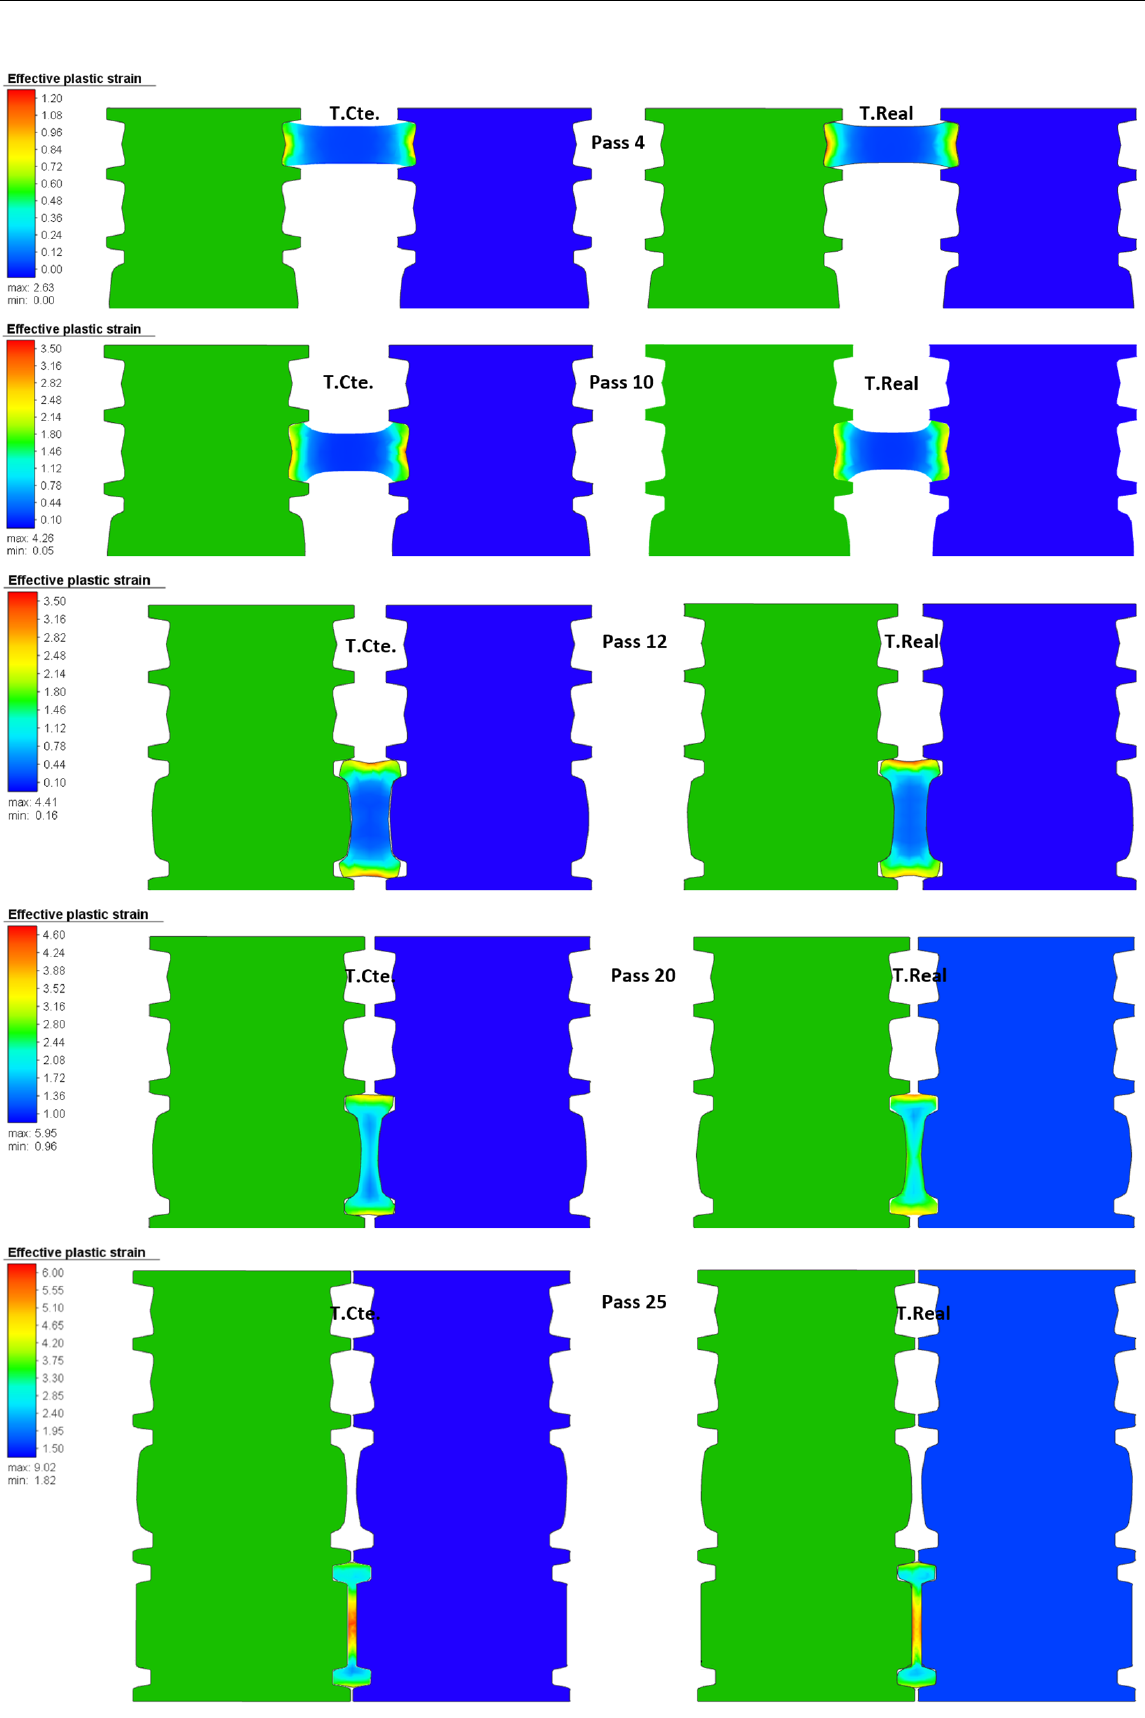
Figure 9. Distribution of effective strain in the middle of the beam during rolling of selected passes for simulations at constant and real